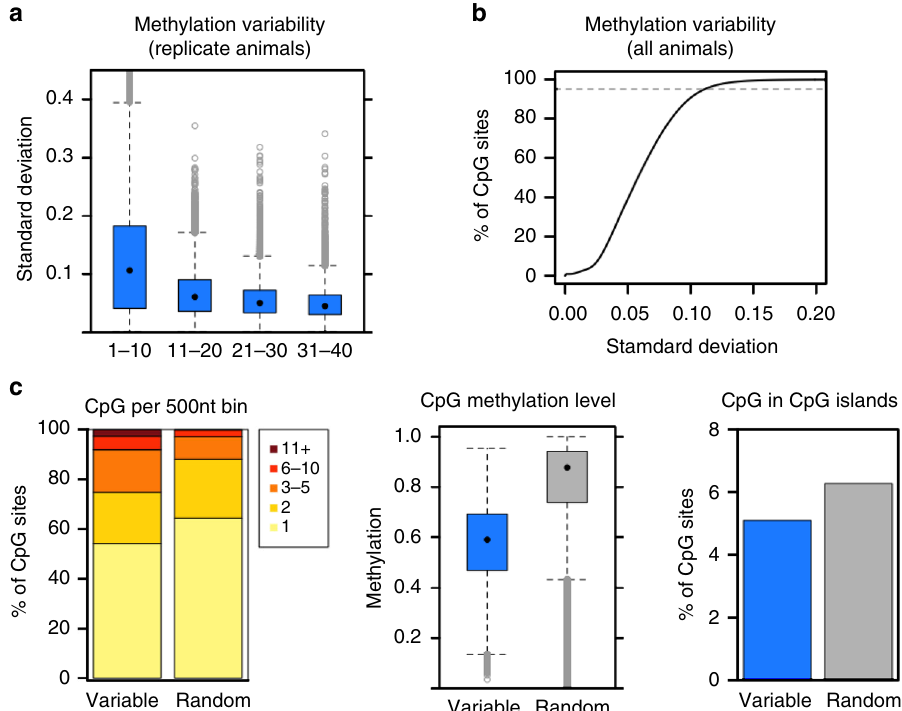
Fig. 1 Variability in methylation observed across animals. a . Standard deviation of methylation level among biological replicates. CpG sites are binned according to site depth, where all replicates (three males and three females) must have depth within the speci fi ed range (e.g., 1 – 10 and 11-20). Totally, 20,000 CpG sites per replicate group (genotype) per depth bin were randomly selected for the boxplot. b Standard deviation of methylation level among all animals shown as a cumulative distribution function. Per-site calculations include only animals with depth at least 10; CpG sites are excluded if most animals lack suf fi cient depth (at least 18 of the 24 study animals must have depth > 10 at the CpG site). The top fi fth percentile (most variable sites) is indicated by a dashed gray line. c Distribution of selected sites in 500 nt tiled windows (left), methylation level of selected sites (middle), and overlap of selected sites with CpG islands (right). Variable refer to sites among top 5% of standard deviation among all animals as in panel B ( N = 871,166); random refer to another 5% of sites ( N = 871,166) meeting the same depth criteria. Color scale in left panel indicates the number of CpG sites per 500nt tiled window. In the box-and-whisker plots, the box depicts the 25th to 75th percentiles, the black dot is the median, the whiskers extend to data points up to 1.5*IQR beyond the box, and open gray circles are data points outside the whisker